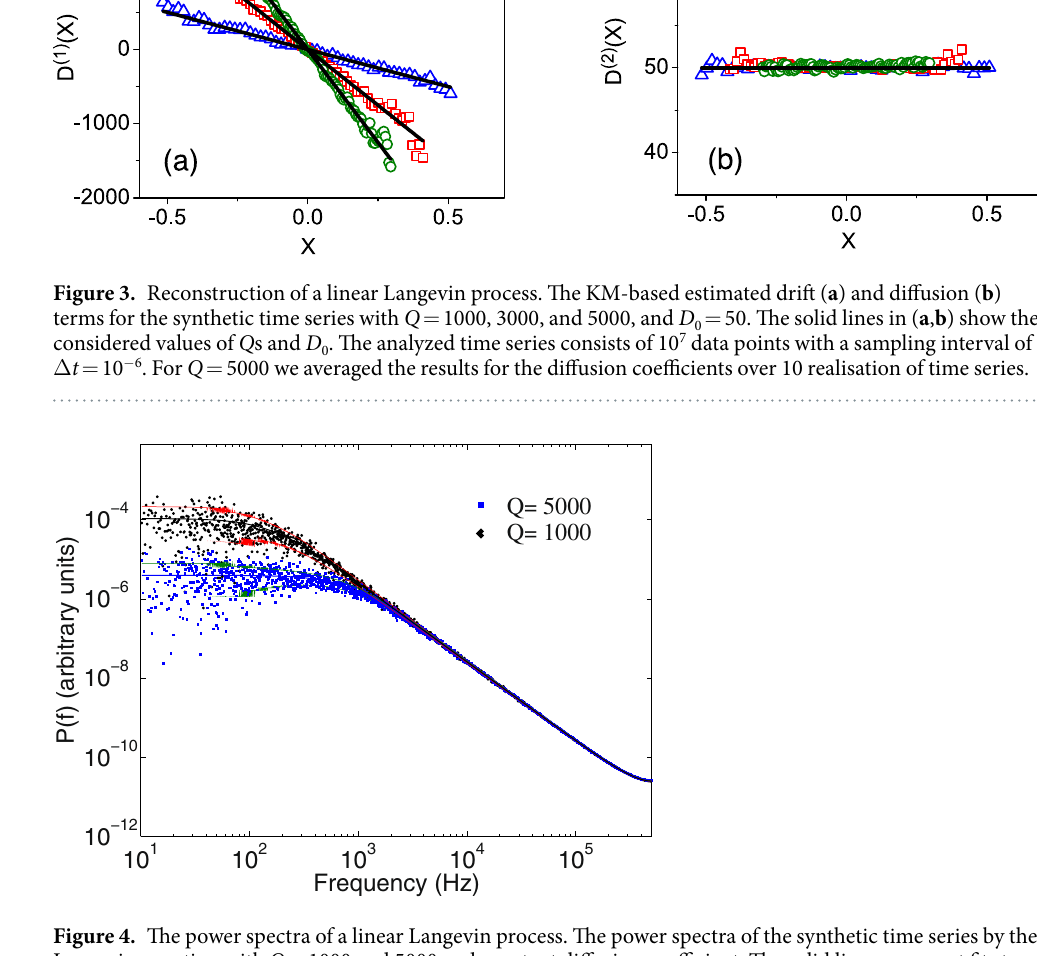
Figure 4. The power spectra of a linear Langevin process. The power spectra of the synthetic time series by the Langevin equation with Q = 1000 and 5000 and constant diffusion coefficient. The solid lines represent fits to Eq. (4). The computed values were Q = 1046 ± 36, 5089 ± 58, and D 0 = 50.6 ± 0.1, 50.9 ± 0.5,